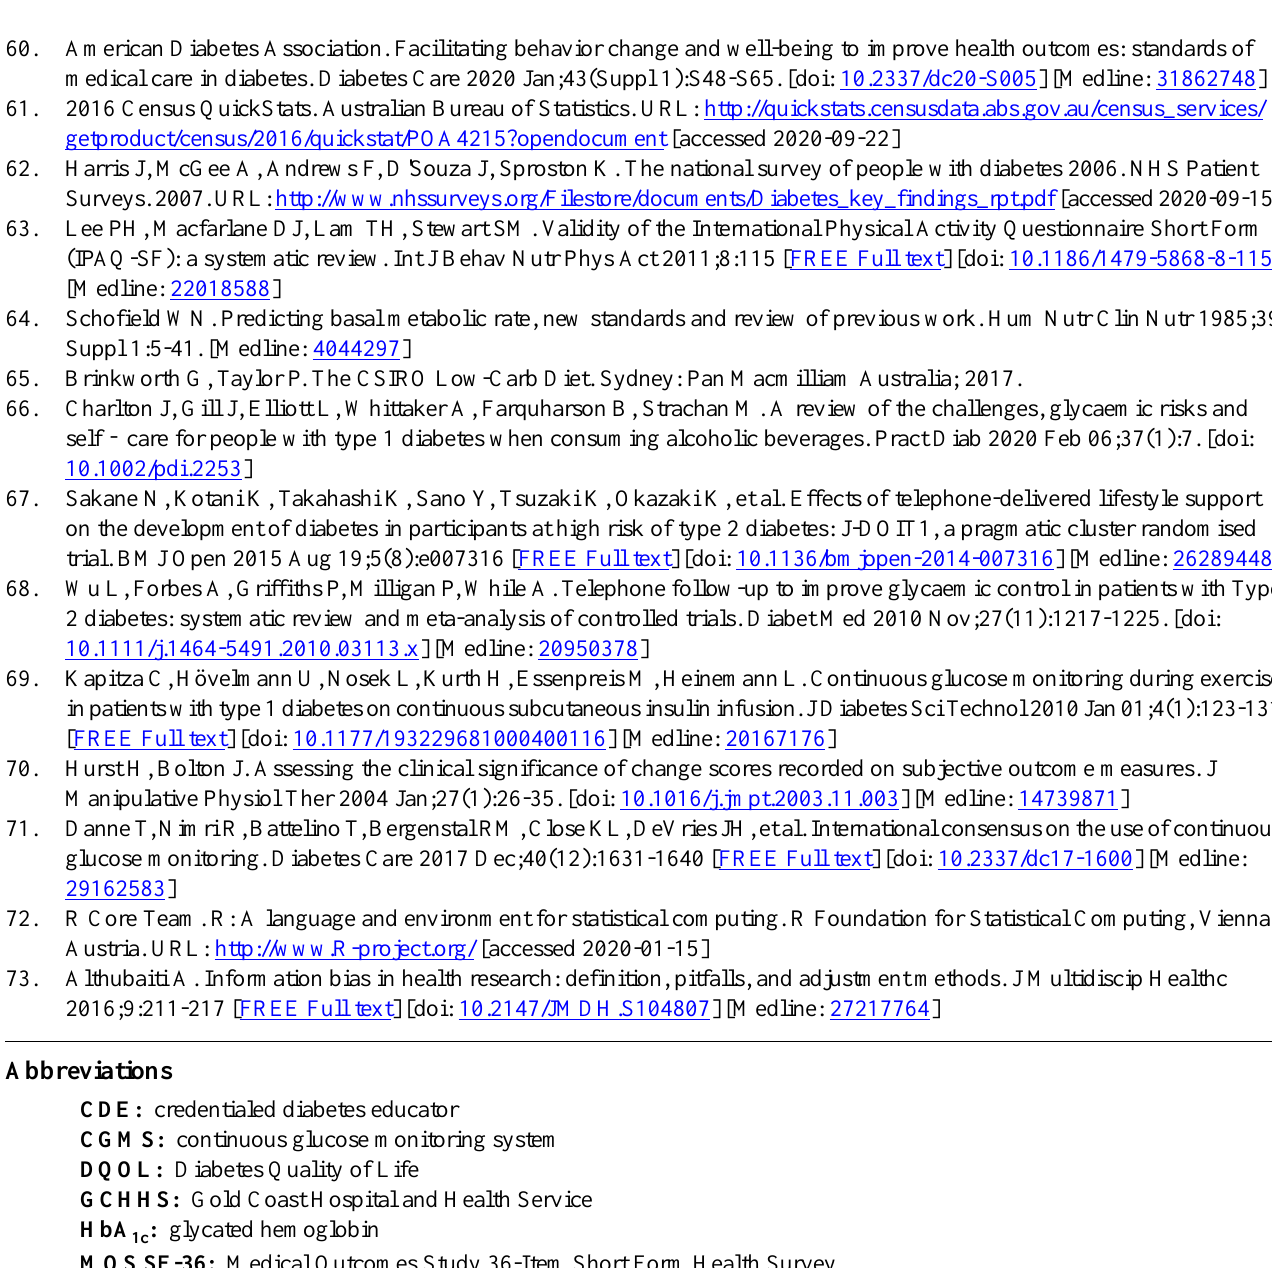
Abbreviations CDE: credentialed diabetes educator CGMS: continuous glucose monitoring system DQOL: Diabetes Quality of Life GCHHS: Gold Coast Hospital and Health Service HbA : glycated hemoglobin 1c MOS SF-36: Medical Outcomes Study 36-Item Short Form Health Survey PAID: Problem Areas in Diabetes QoL: quality of life QR: quick response SERTA: Study, Education and Research Trust Account T1DM: type 1 diabetes mellitus T2DM: type 2 diabetes